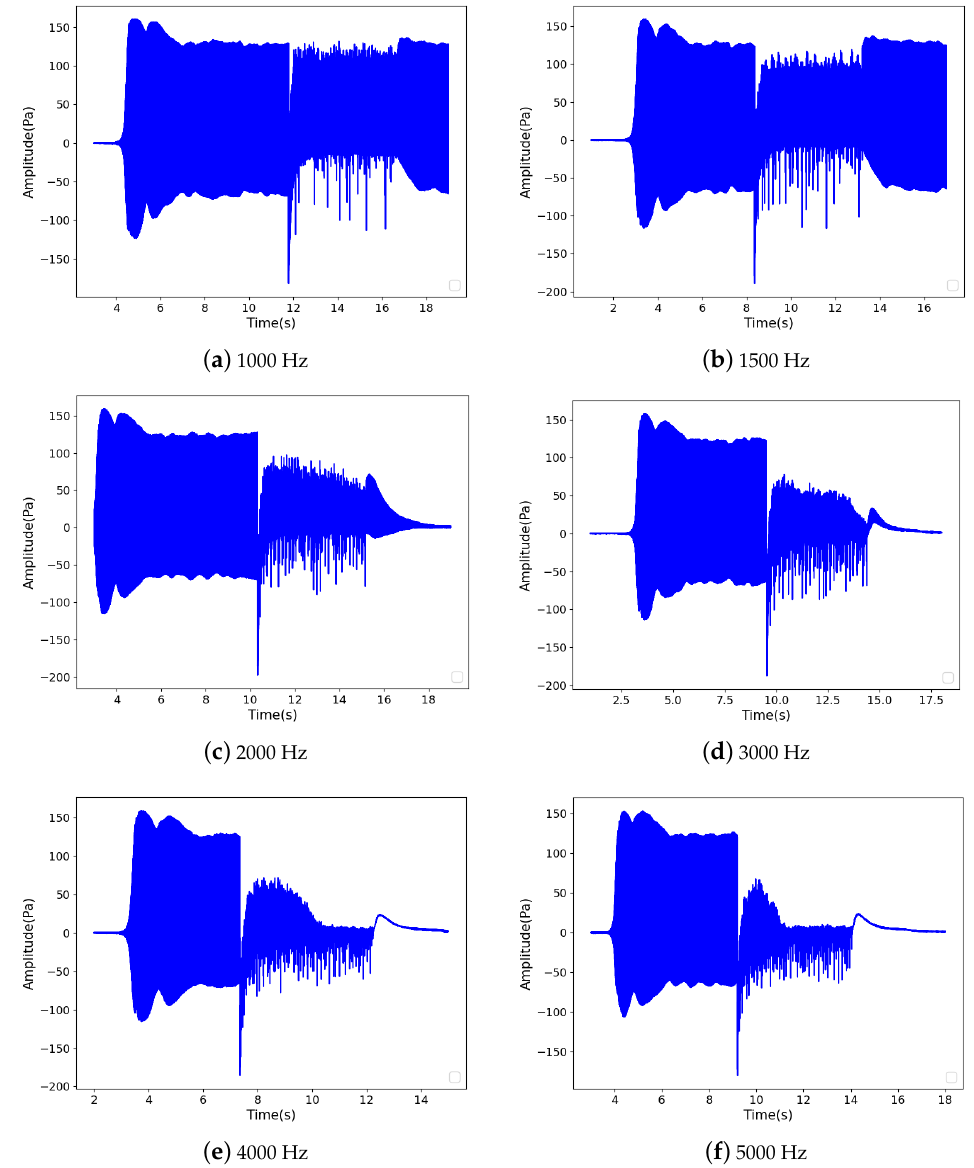
Figure 7. Pressure data when discharge was applied at different repetition rates (heating power: 1.37